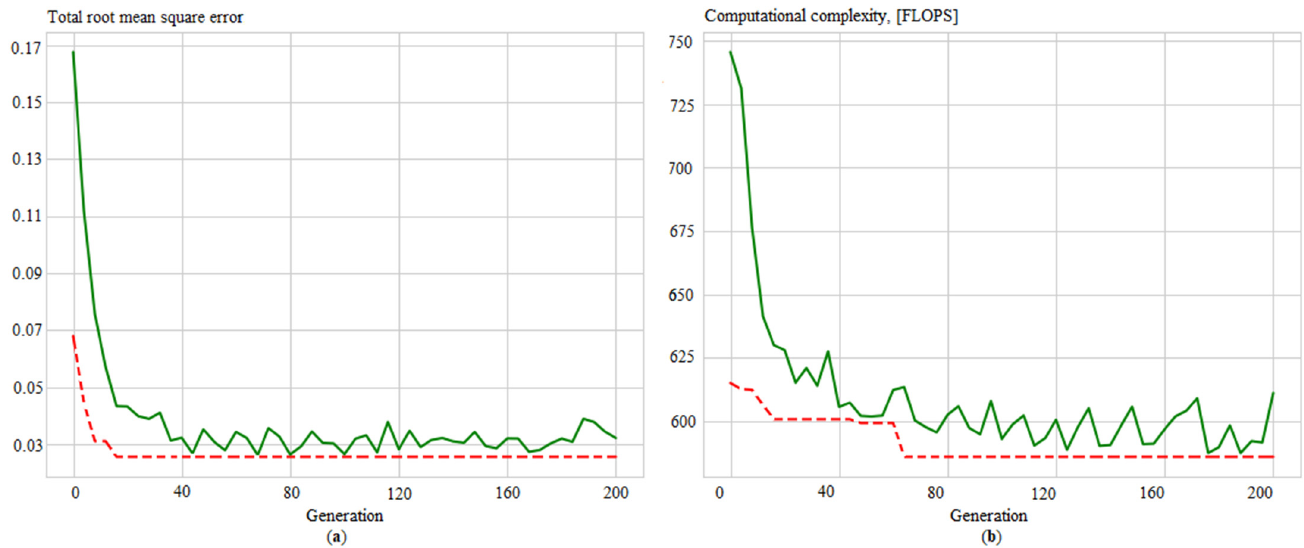
Figure 14. Evolution of the ANN predict in the process of determining its best structure by: ( a ) total root mean square error; ( b ) computational complexity, where solid green lines are average values per generation, and dotted red lines are mini- mum values per generation.